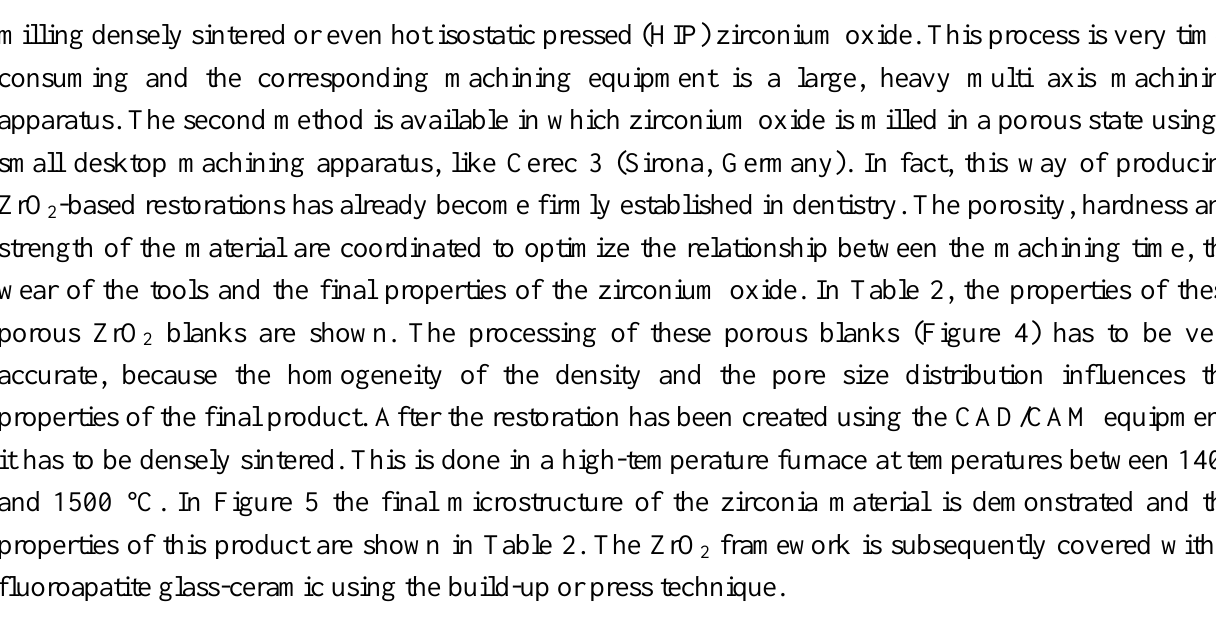
Figure 4. Image of the presintered product IPS e.max  ZirCAD, Ivoclar Vivadent AG, with the metal holder for CAD/CAM-technology.